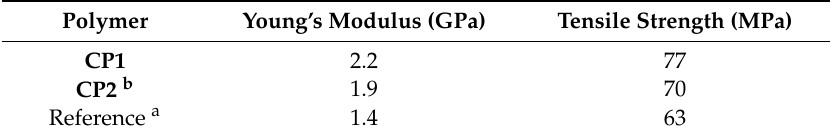
Table 3. Mechanical properties of CP1 and CP2